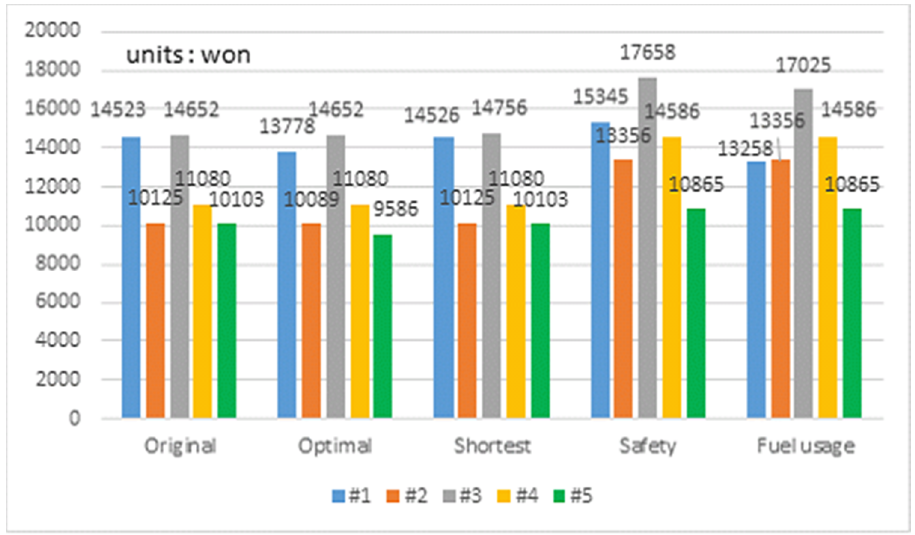
Figure 11. Compare Cost by path.